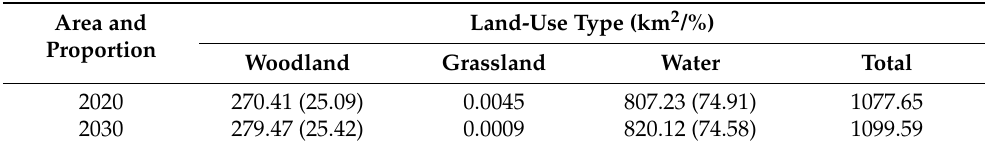
Table 2. Land-use area and percentage of ecological sources in